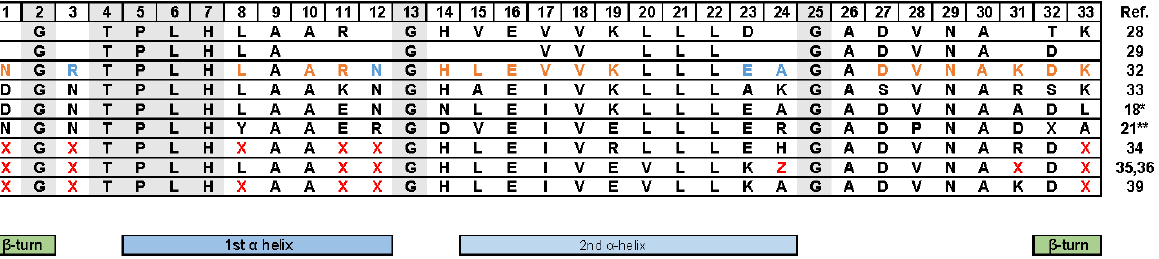
Figure 2. Ankyrin repeat consensus sequence. Letter refer to amino acids (1 letter code). Residue are numbered according to the UniProt annotation of the ankyrin repeat motif. In black: conserved residue. In blue: non ‐ conserved residue. In orange: semi ‐ conserved residue. X = any amino acid, except C, G, and P. Z = H, N, or Y. * bacterial sequence consensus. ** archea sequence consensus. The amino acids that are structurally important are highlighted in grey [18,21,28,29,32–36,39].